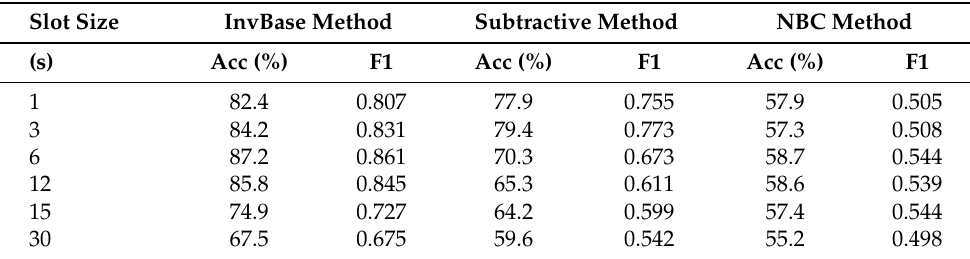
Table 5. Valence classification accuracies and F1 scores of InvBase, subtractive, and NBC methods using MLP with various slot sizes.